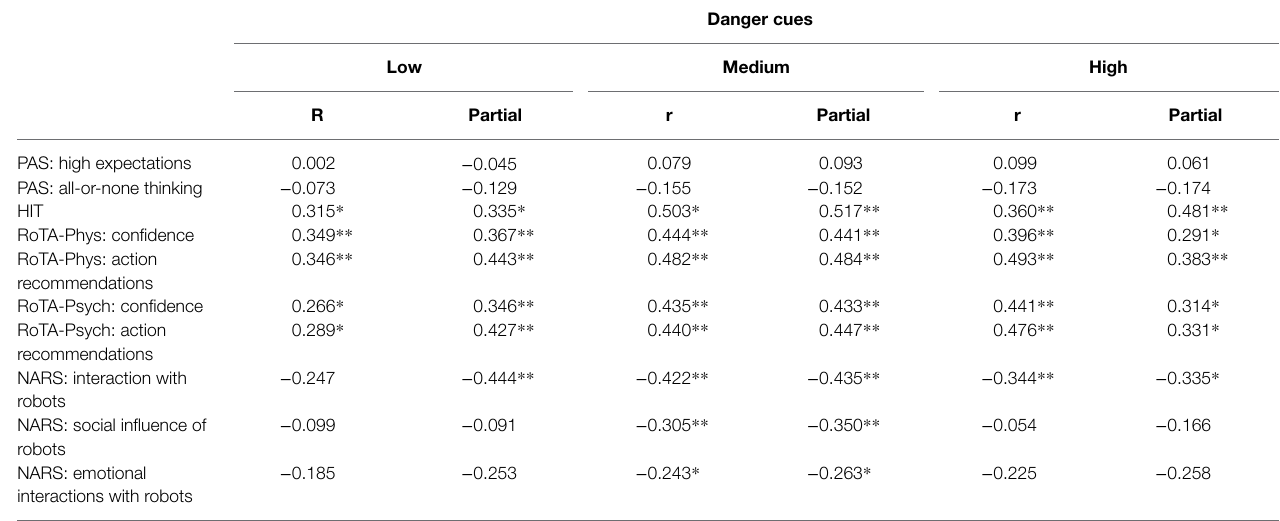
TABLE 7 | Correlations between selected predictors and mean trust rating at each level of danger cues, in psychological